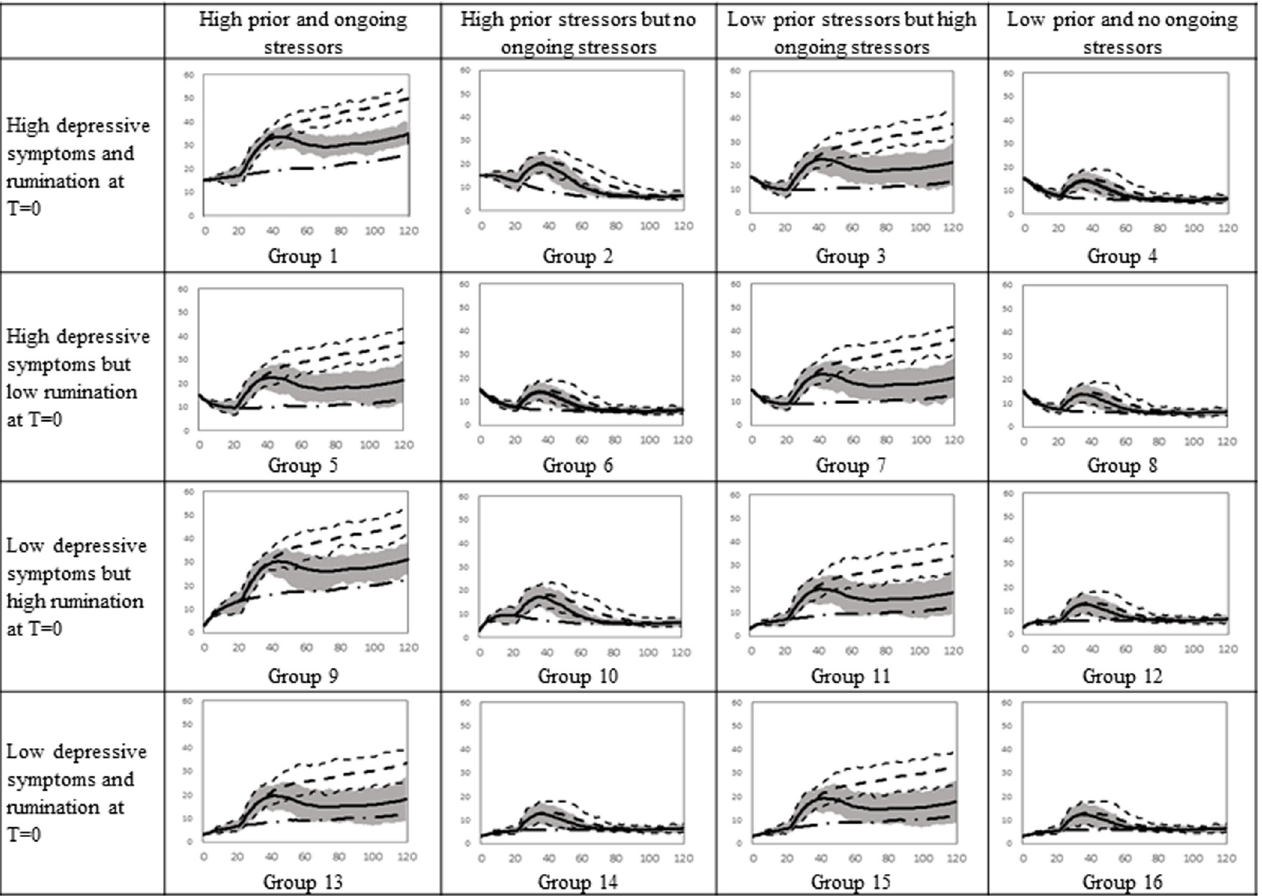
Fig 5. Simulated depressive symptoms for 16 male groups who experienced a stressful life event at month 20 and therapy at month 30. The long-dash-dot captures the baseline output. The dashed line depicts the depressive symptoms when boys experience a stressful life event at month 20. The solid line shows the results when they experience a stressful life event at month 20 and then therapy at month